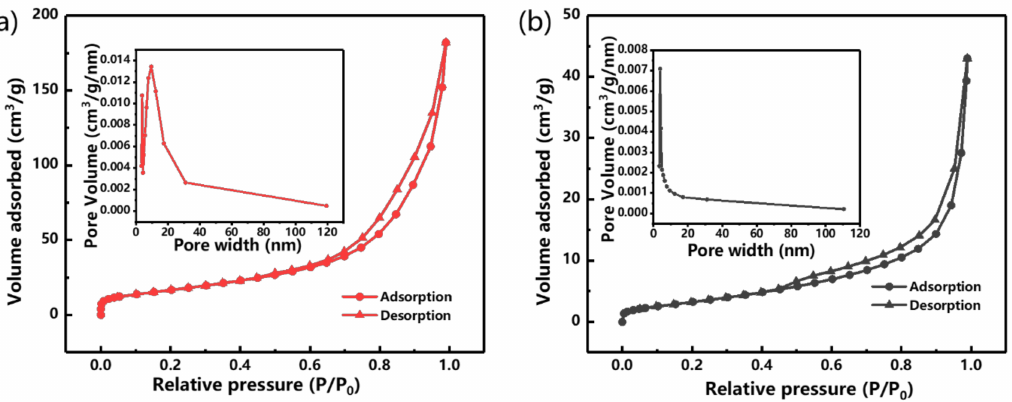
Figure 4. Nitrogen adsorption and desorption isotherm of ( a ) Co 3 O 4 /rGO and ( b ) Co 3 O 4 with the pore size distribution in the